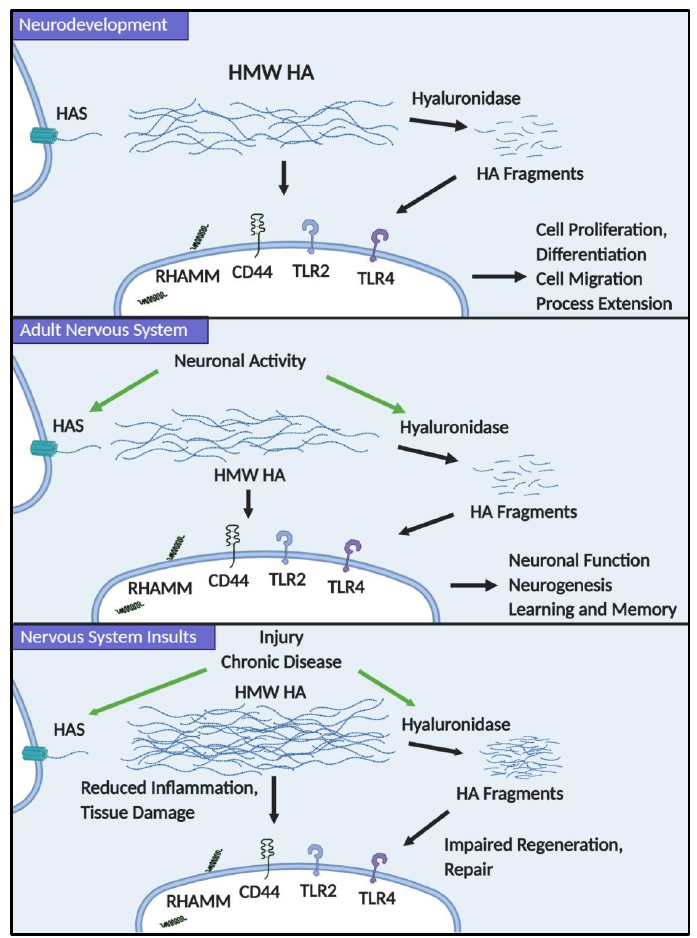
Figure 1. Hyaluronic acid (HA) has diverse functions in neurodevelopment, the adult nervous system, and in nervous system disease. During neurodevelopment, changes to HA in the extracellular matrix (ECM) through the modulation of HA synthases (HAS) and hyaluronidase expression and activity help regulate neural stem and progenitor cell proliferation and differentiation, as well as migration and process extension of different neural cell lineages. In the adult nervous system, neuronal activity